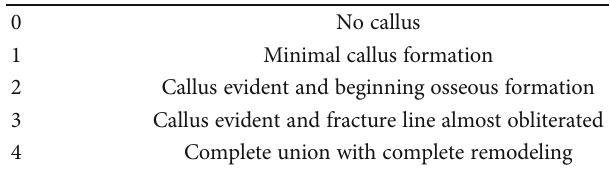
Table 2: The Lane-Sandhu